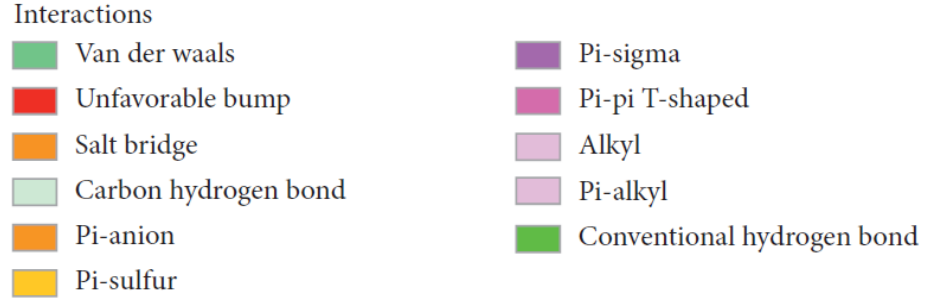
Figure 5. Binding orientation of potential inhibitors at the binding site of the AChE enzyme, suggested on the basis of molecular docking studies.